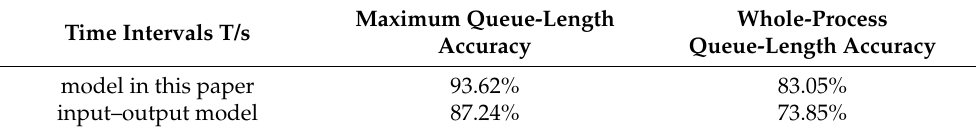
Figure 17. Comparison of calculation results of queue length of different models. Table 8. Accuracy comparison between the proposed model and the input–output